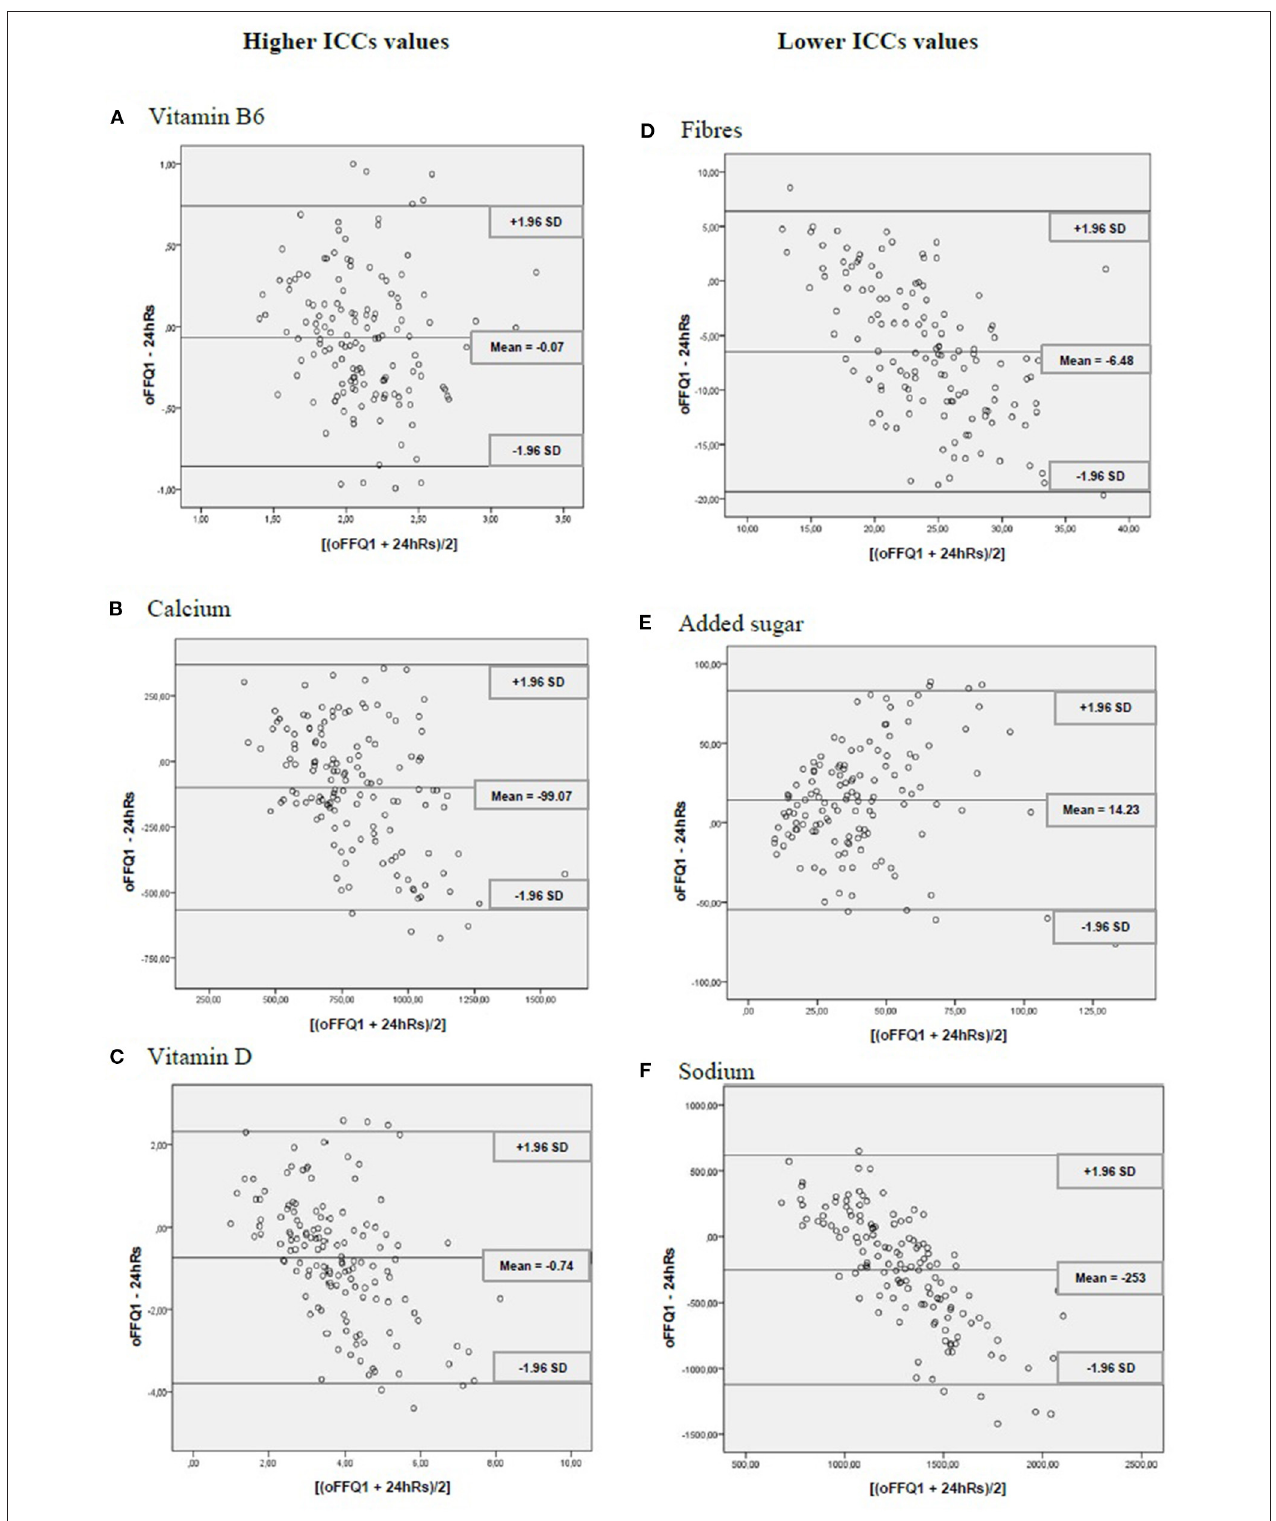
FIGURE 2 | Dispersion analyses for vitamin B6, calcium, vitamin D, fiber, added sugar, and sodium between the online food frequency questionnaire (oFFQ1) and the 24-h recall (24h Rs) ( n = 146 participants). CUME Project, 2019. ICCs, intraclass intervals. SD, standard deviation.